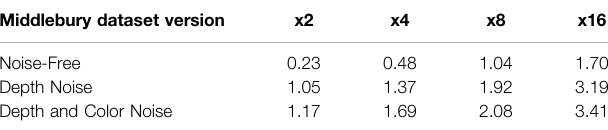
TABLE 4 | Average RMSE Values of Our Proposed architecture for Different Scaling Factors on Various